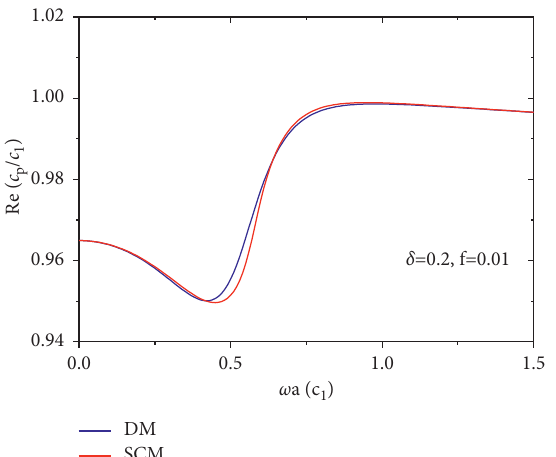
Figure 4: Comparison of ratios of the phase velocity in the composite material and matrix obtained by the differential method (DM) and self-consistent method (SCM) when quasi-P wave propagates in the composite material for inclusion volume fraction of 1% and δ � 0 . 2.